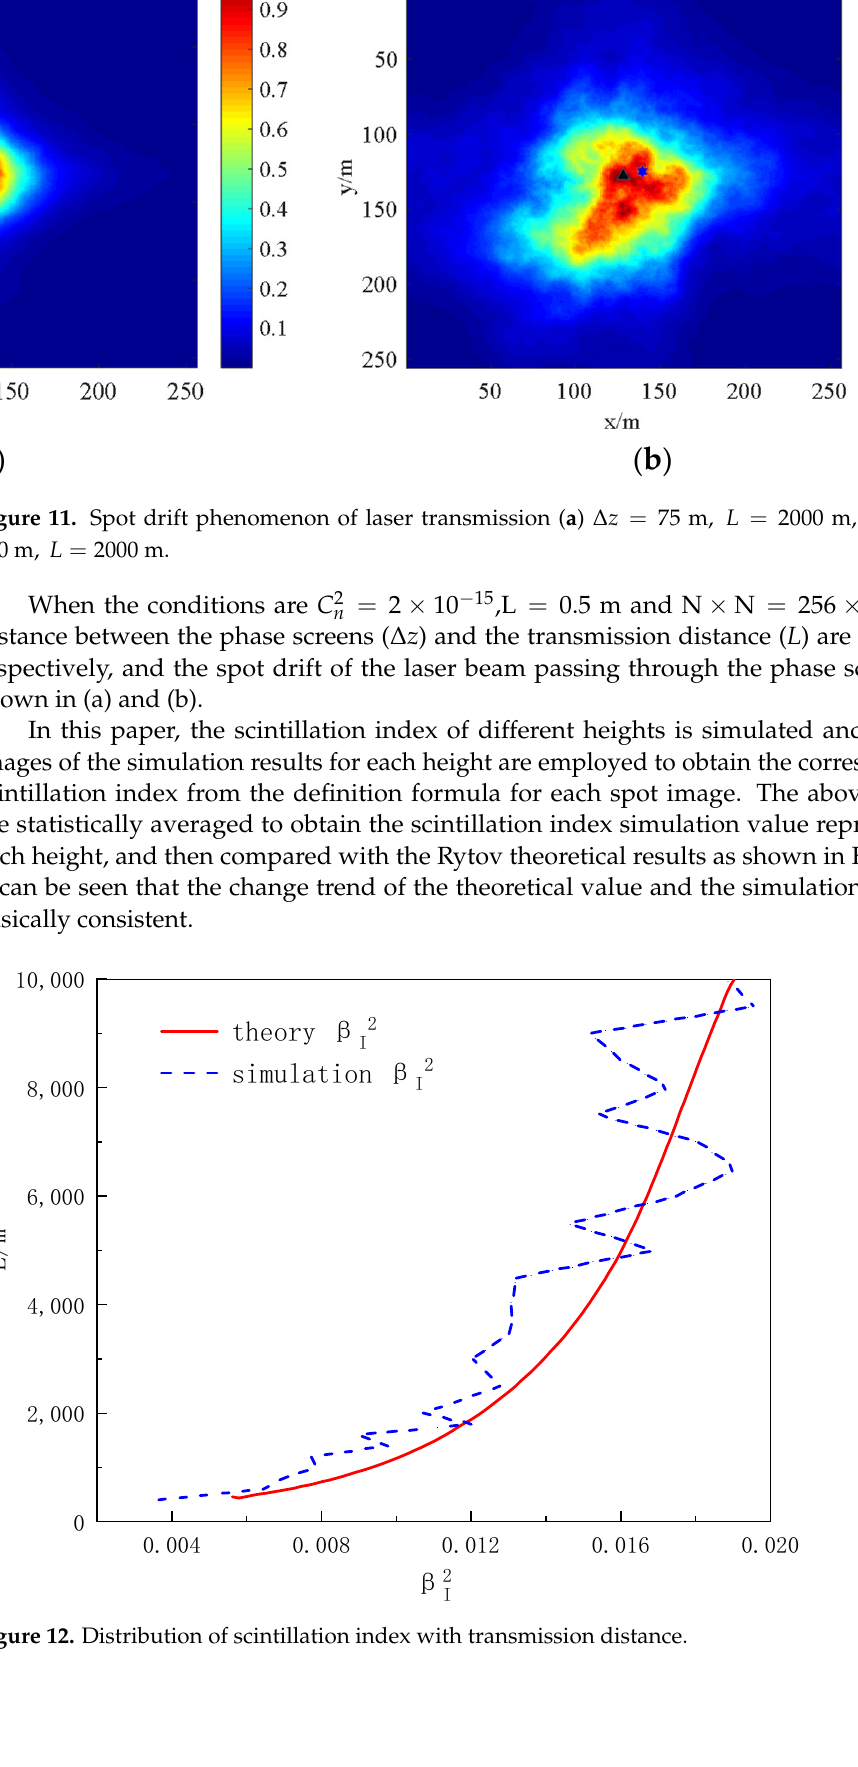
Figure 12. Distribution of scintillation index with transmission distance. 0.004